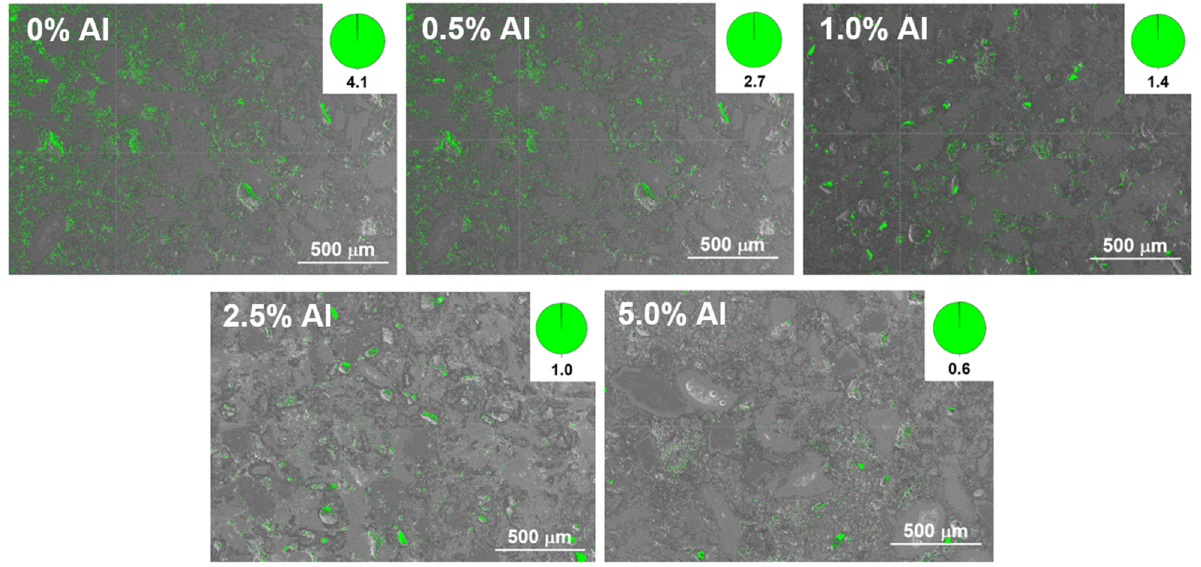
Figure 3. SEM-SE micrographs of CrCuFeNiTiAlx alloys with different porosity levels as a function of added Al.